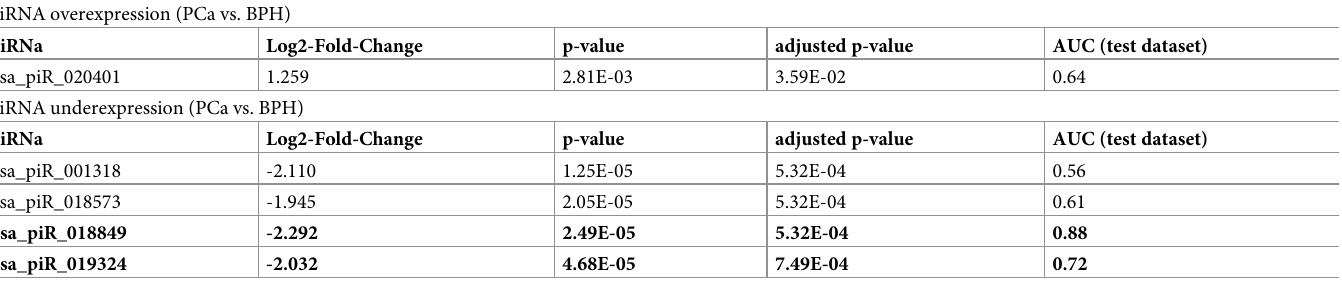
Table 4. Differentially expressed total